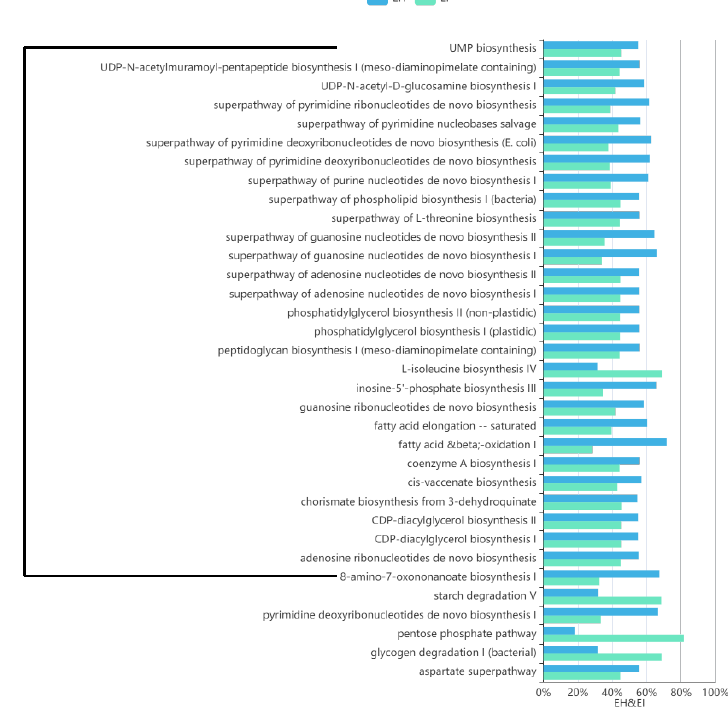
Figure 10. Map of predicted MetaCyc functional pathway differences. The abscissa represents the abundance of functional pathways (relative abundance); the left side of the ordinate shows the MetaCyc functional pathway. (EH: emergence period, healthy; EI: emergence period, infested).